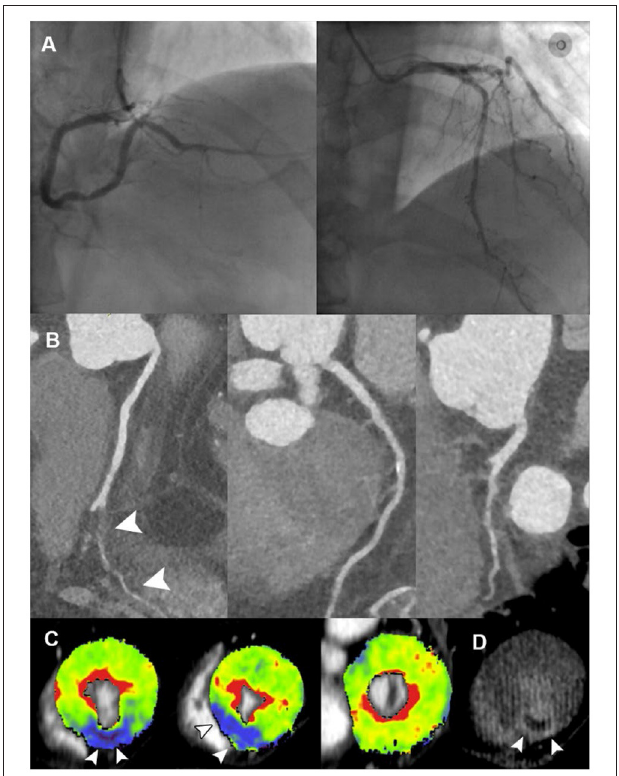
FIGURE 2 | Representative case of vessel occlusion with MVO in a 66-year-old male with ACS and non-obstructive ICA. (A) ICA revealed mild stenosis at middle LAD and distal RCA, without presence of obstructive lesion. (B) CPR images showed occlusion of PDA ostium (white arrowhead). (C) Short-axis views of CT-MPI showed significantly reduced myocardial blood flow within PDA territory (white arrowhead). (D) LIE image showed the transmural late enhancement with the presence of MVO within PDA territory (white arrowhead). ACS, acute coronary syndrome; CPR, curved planar reformation; CT, computed tomography; ICA, invasive coronary angiography; LAD, left anterior descending; LIE, late iodine enhancement; MPI, myocardial perfusion imaging; MVO, microvascular obstruction; PDA, posterior descending artery; RCA, right coronary artery.